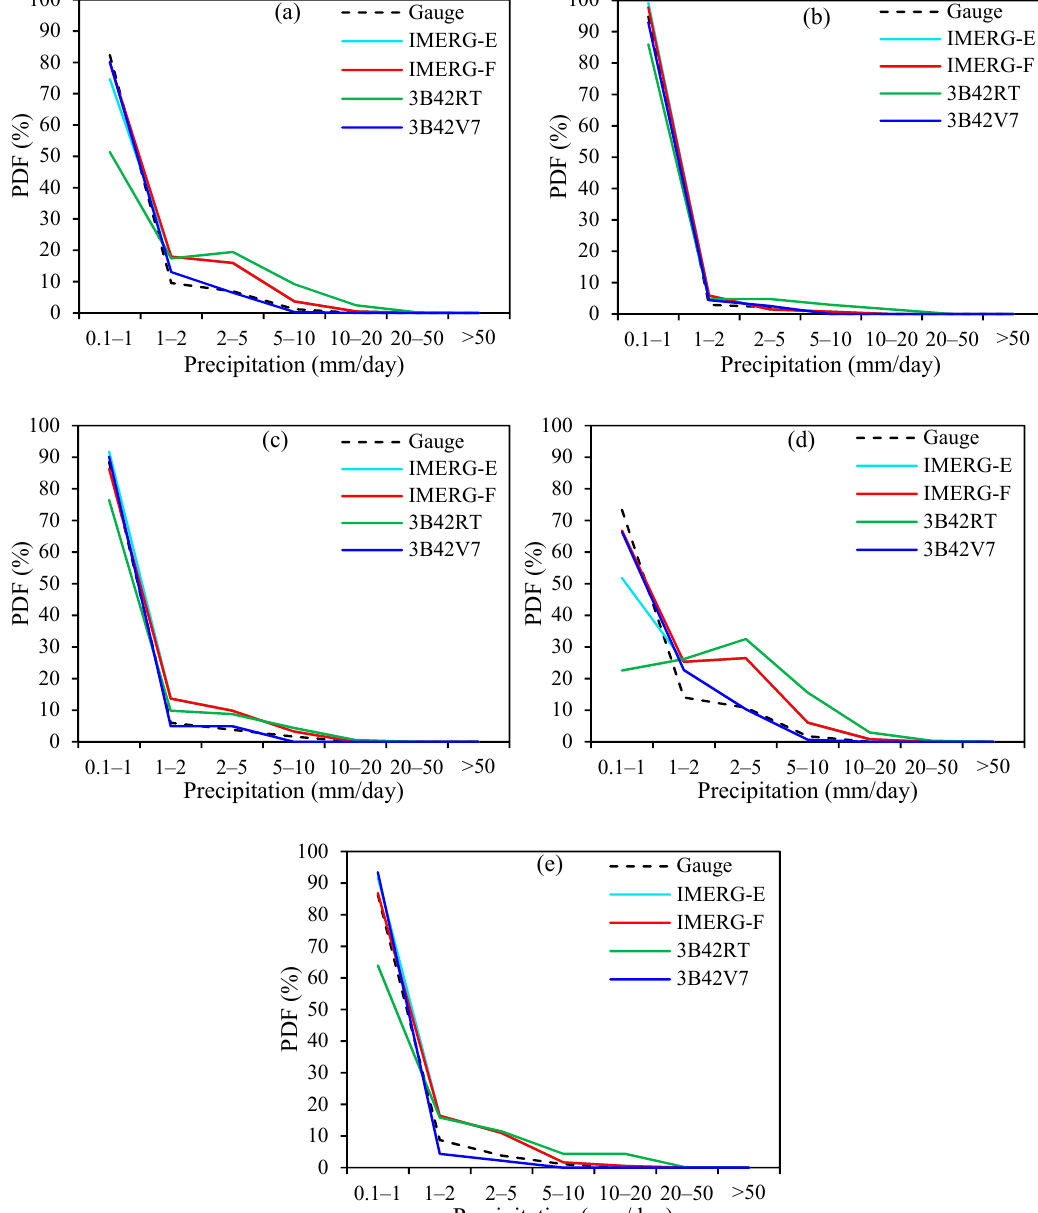
Figure 8. The probability distribution function (PDF) of daily precipitation at different thresholds, as obtained from the in situ gauges, IMERG-E, IMERG-F, 3B42RT, and 3B42V7 products in ( a ) the entire period, ( b ) winter, ( c ) spring, ( d ) summer and ( e ) autumn.